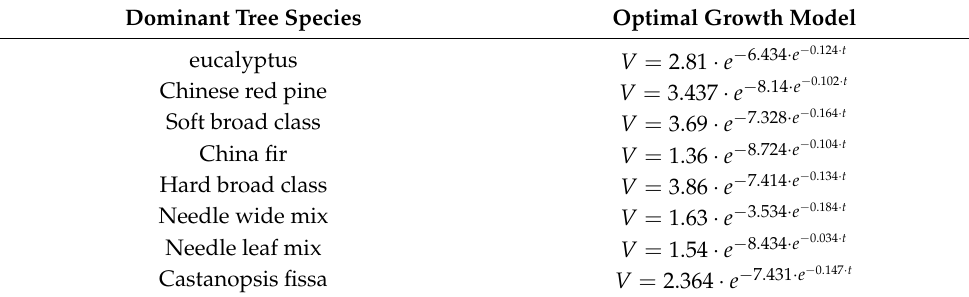
Table 4. Best growth models for the predominant tree